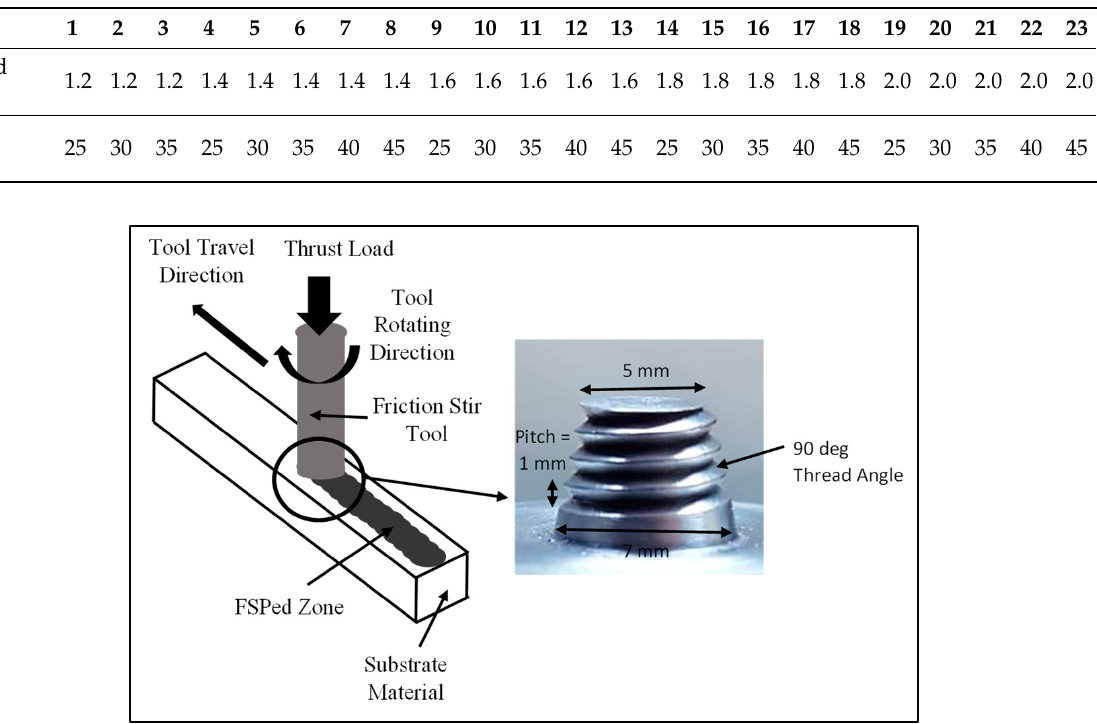
Figure 2. Schematic diagram of FSPed recycled AA 6063.